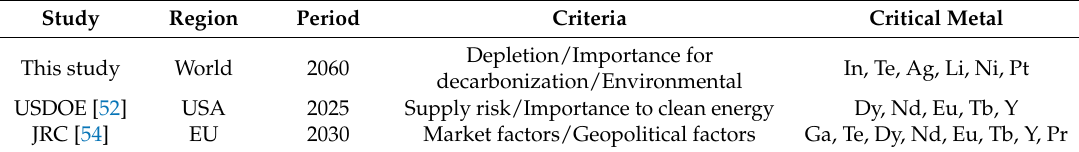
Table 10. Comparison of this study to previous studies which evaluated critical